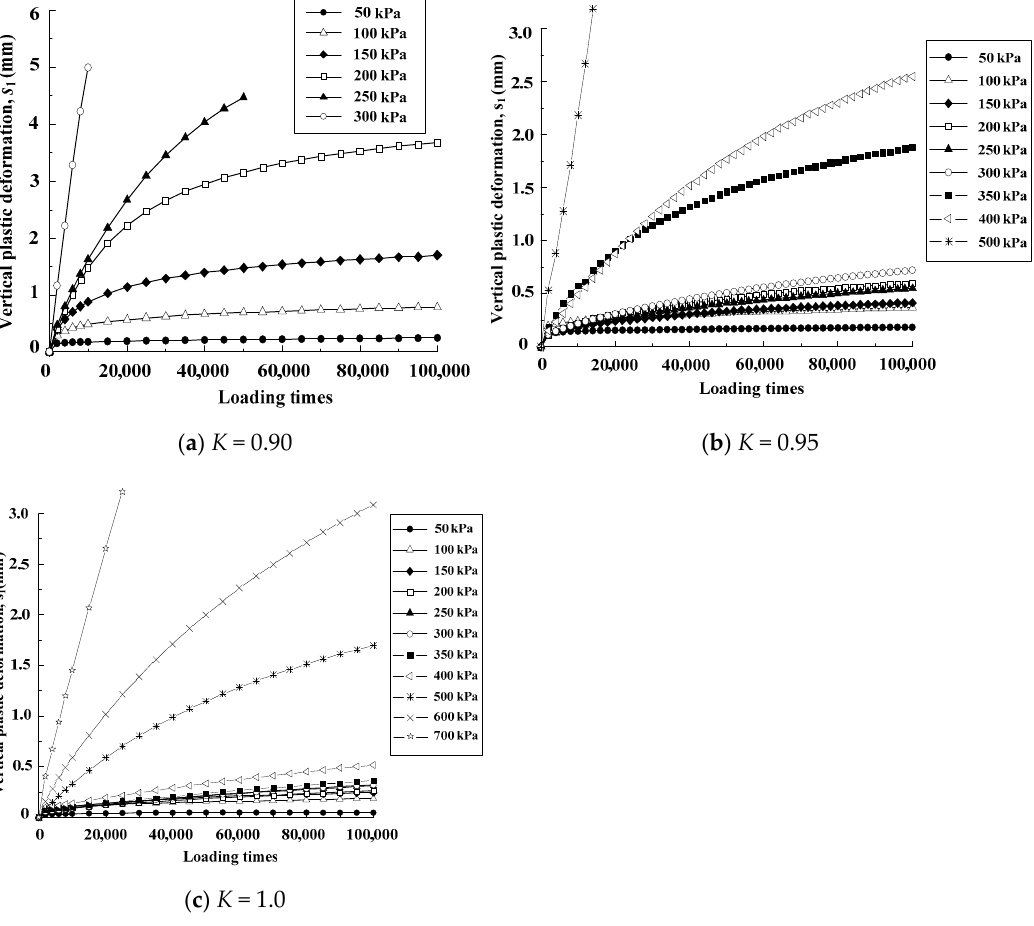
Figure 8. Vertical plastic deformation against loading times for ( a ) Model 1, ( b ) Model 2, and ( c ) Model 3.